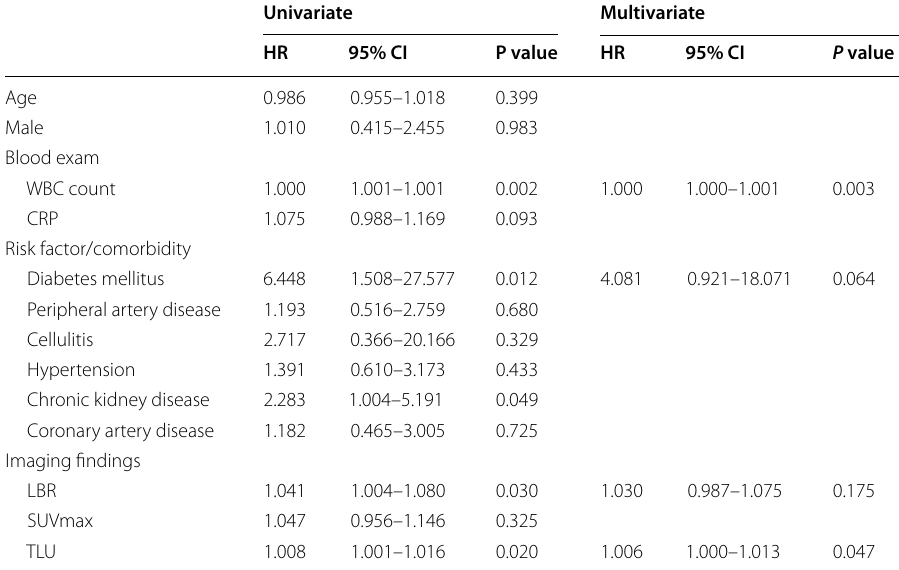
HR hazard ratio; CI confidential